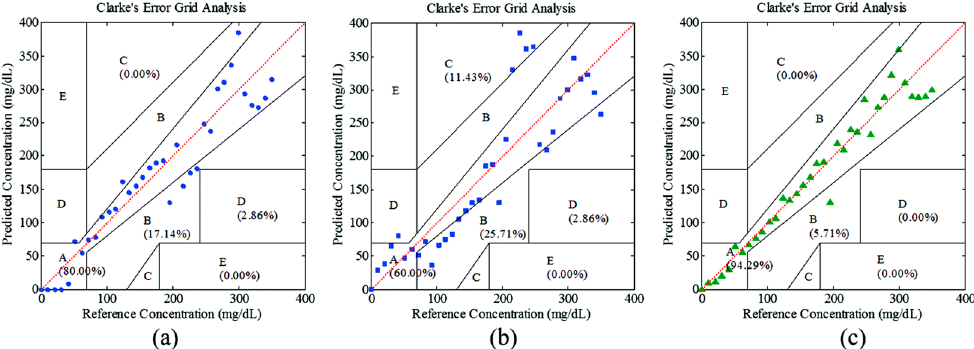
Figure 5. Correlations between references and predicted glucose concentrations shown in CEGs by using ( a ) the PA amplitude, ( b ) the time delay, and ( c ) a data fusion. Reprinted with permission from [101].